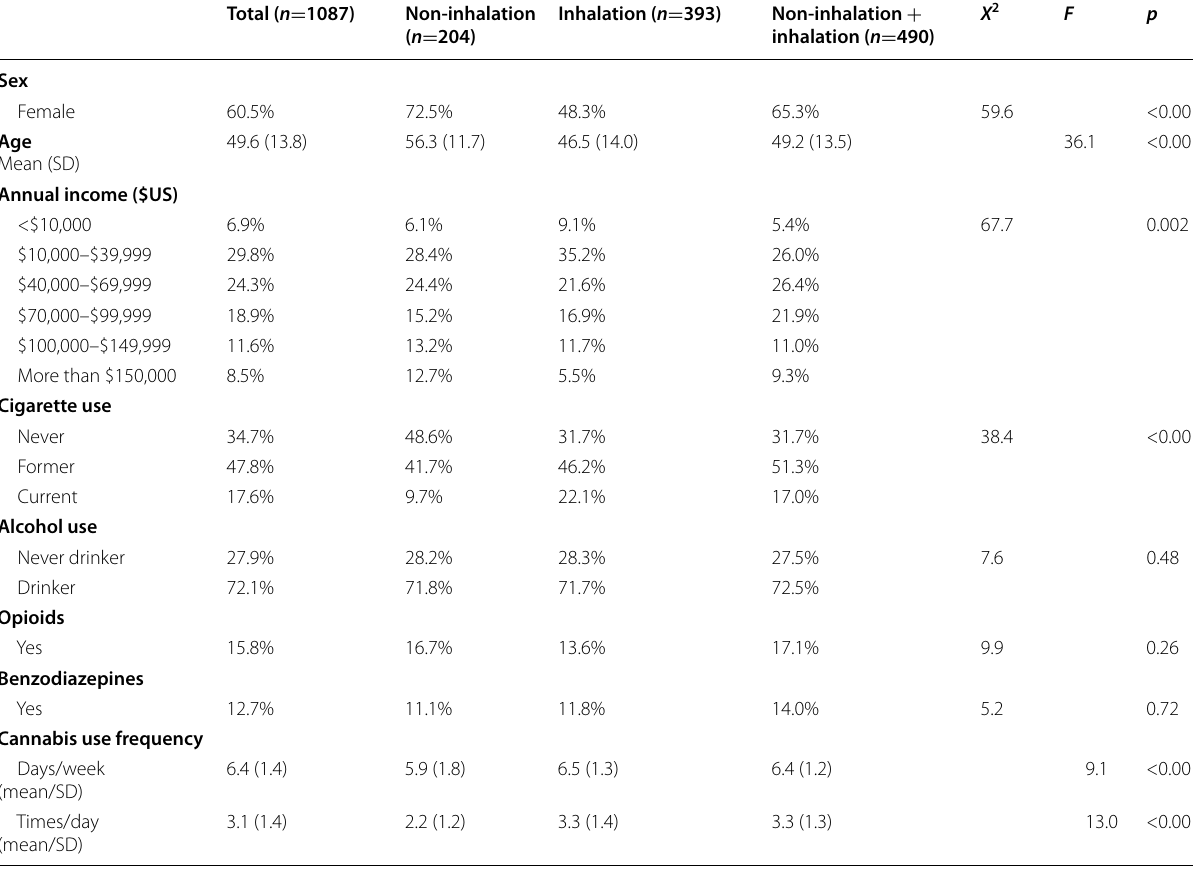
Demographics of each cannabis use routine subgroup